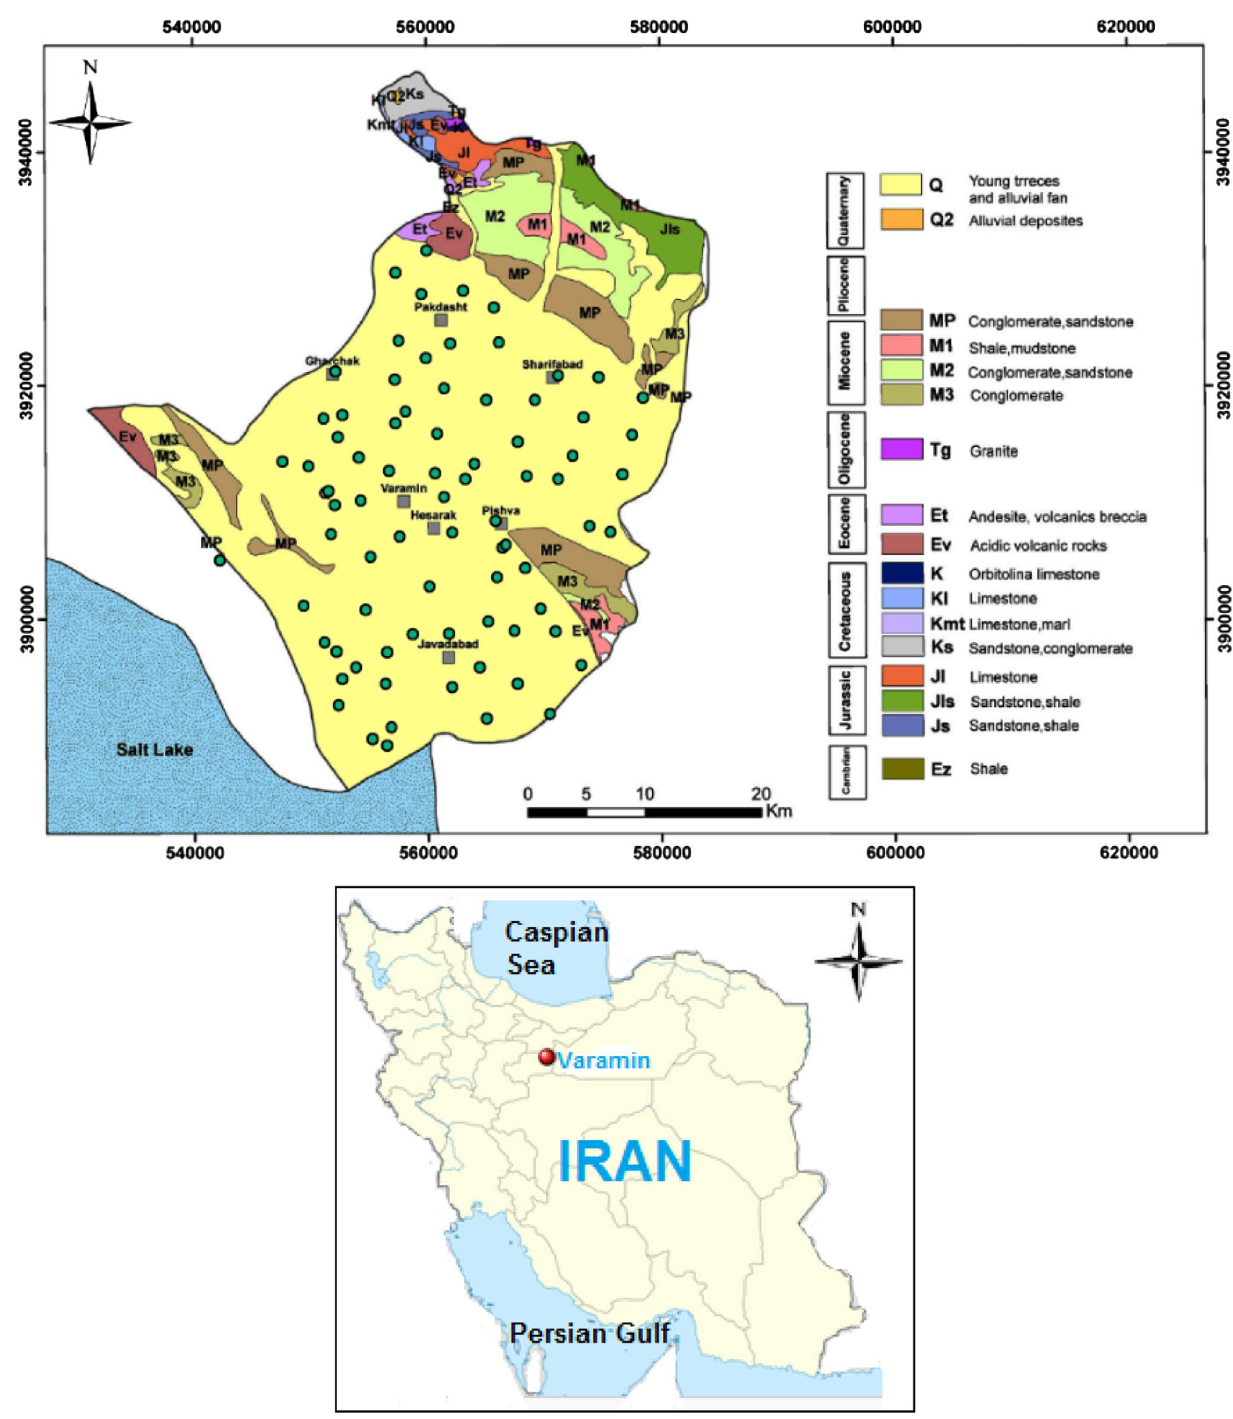
Fig. 1 Sampling locations on the geological map of the Varamin